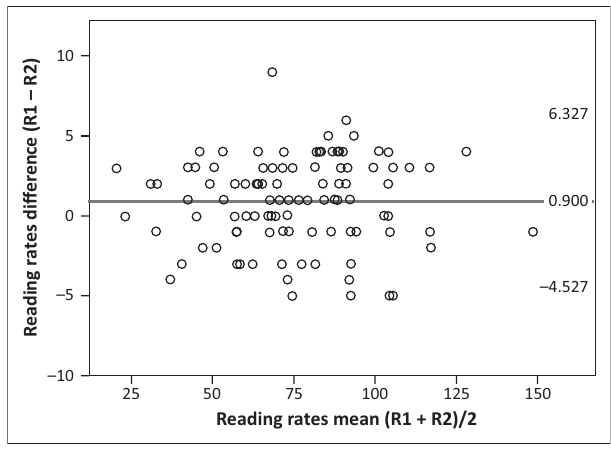
FIGURE 7: Differences between reading rate measurements for individual learners obtained with the Wilkins test and the paediatric rate of reading chart are plotted against the averages of these data according to the Bland and Altman method. The upper and lower confidence intervals are represented by dotted lines.